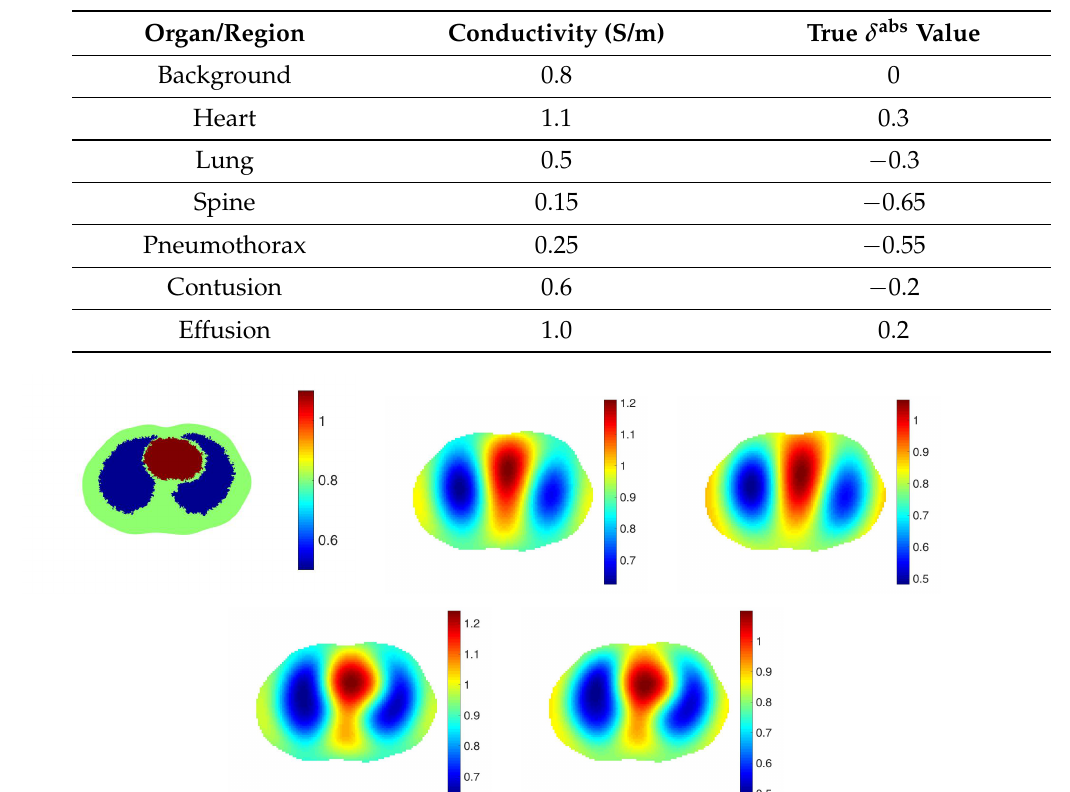
Figure 2. Healthy heart and lungs. From left: Reconstruction of γ abs with no prior, γ diff with no prior, γ abs pr with the spatial prior, γ diff with the spatial prior. The L2 norms of the difference between those reconstruction and the ground truth, the first figure, are 0.2952, 0.3119, 0.2920 and 0.3085 in order.